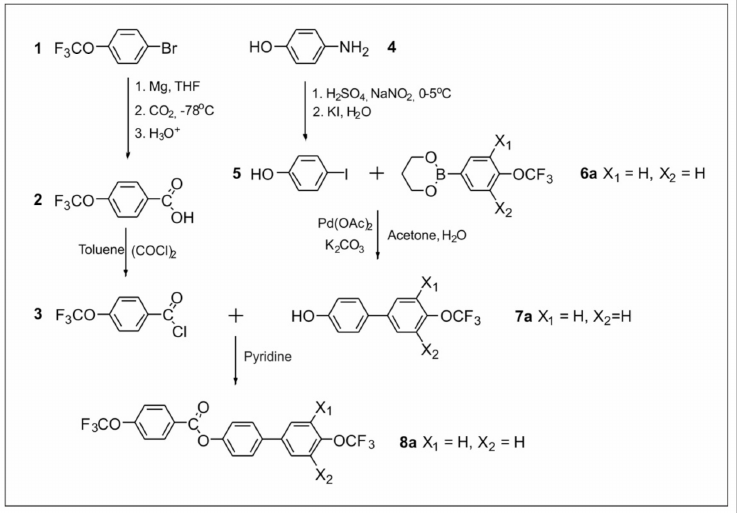
Figure 2. Synthesis of 4 (cid:48) -(trifluoromethoxy)-[1,1 (cid:48) -biphenyl]-4-yl 4-(trifluoromethoxy) benzoate 8a (variant